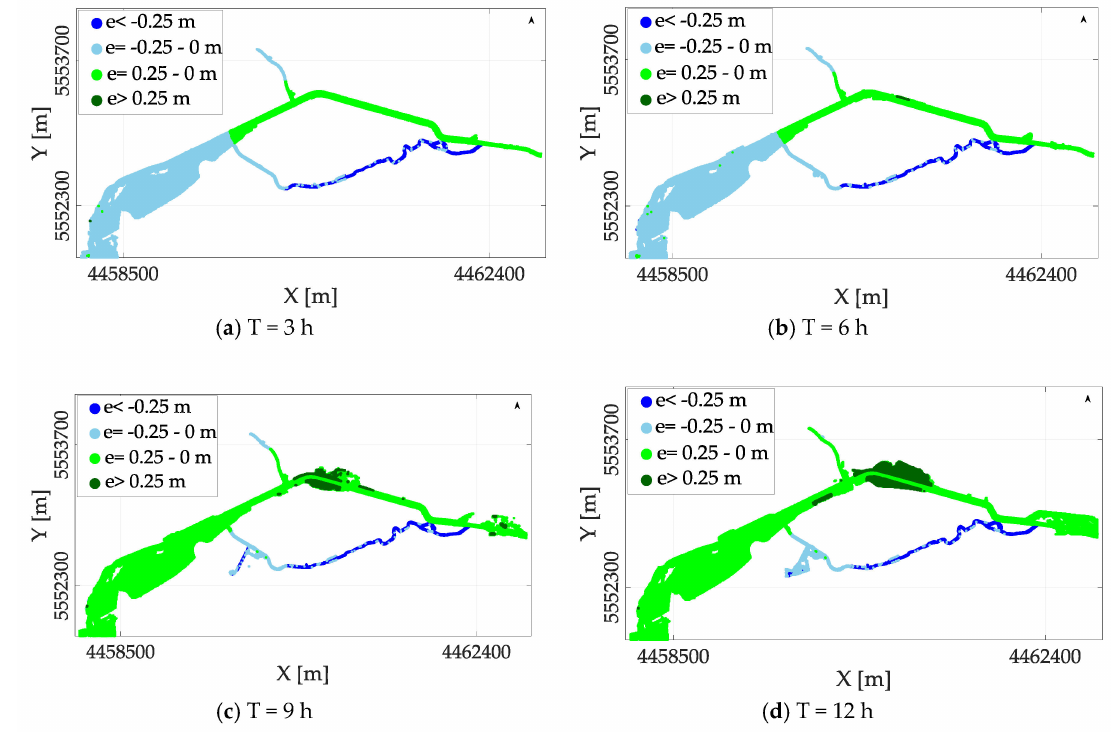
Figure 12. Water depth error between offline and online for January 2011: ( a ) T = 3 h, ( b ) T = 6 h, ( c ) T = 9 h and ( d ) T = 12